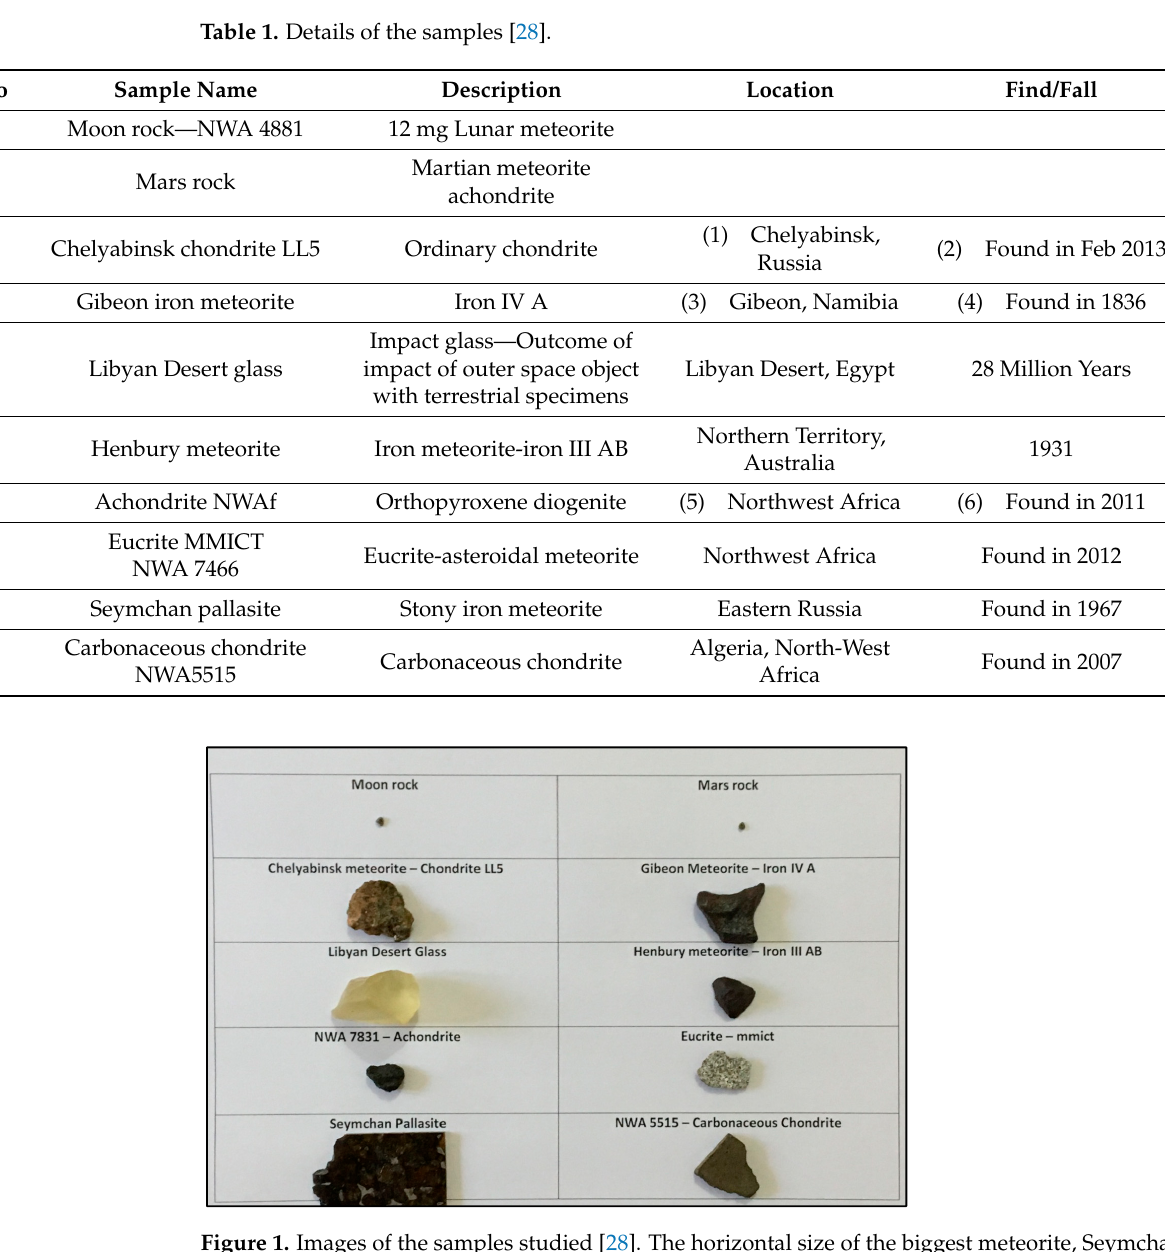
Figure 1. Images of the samples studied [28]. The horizontal size of the biggest meteorite, Seymchan pallasite, is 3cm.